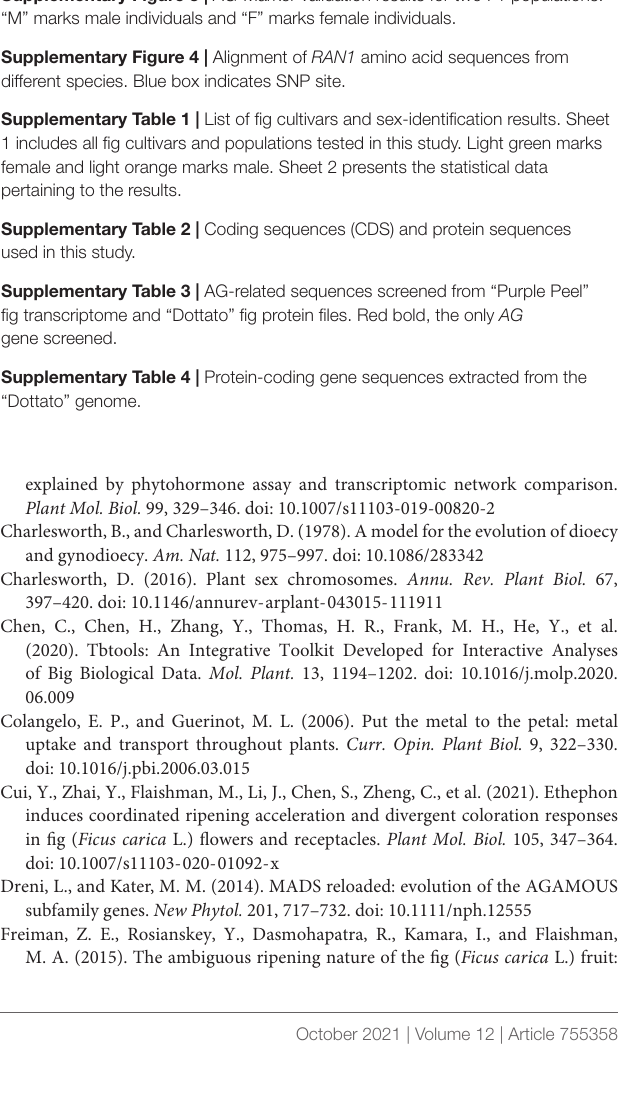
Supplementary Figure 1 | Full-length alignment of Ficus AG genes.